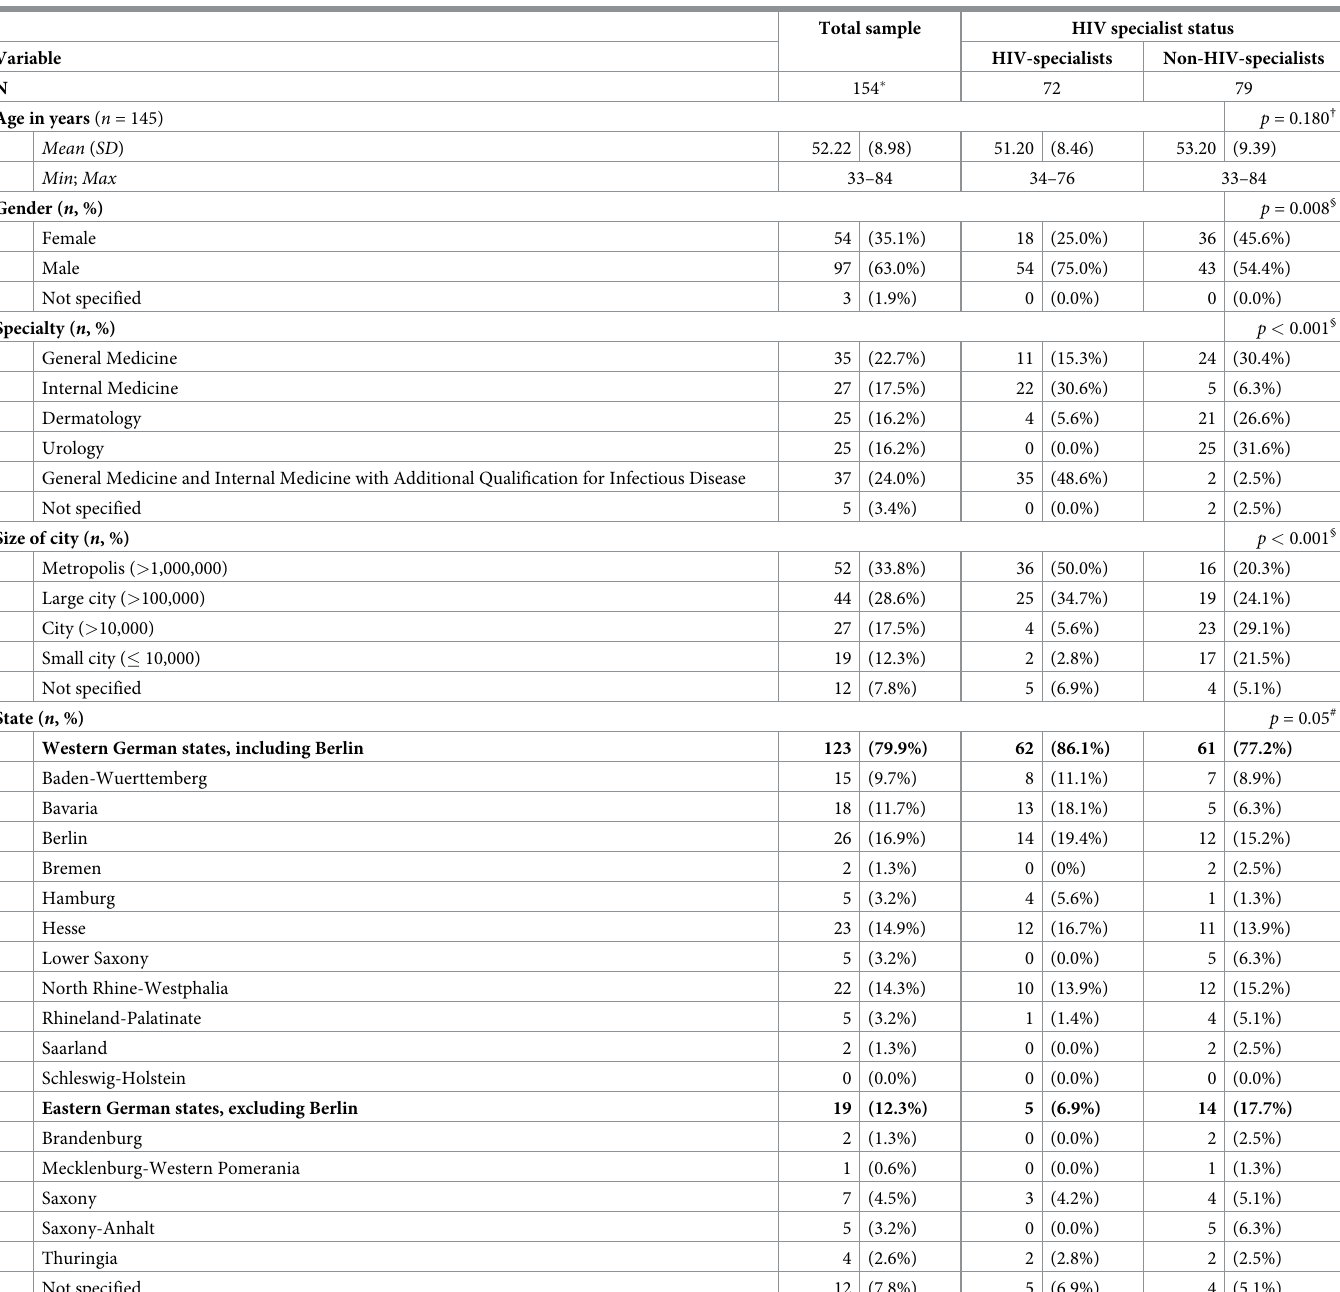
Table 1. Demographic data and contextual characteristics of the